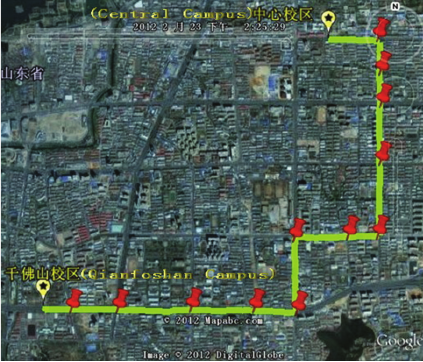
Figure 3: Driving route of the school bus from Google Earth.